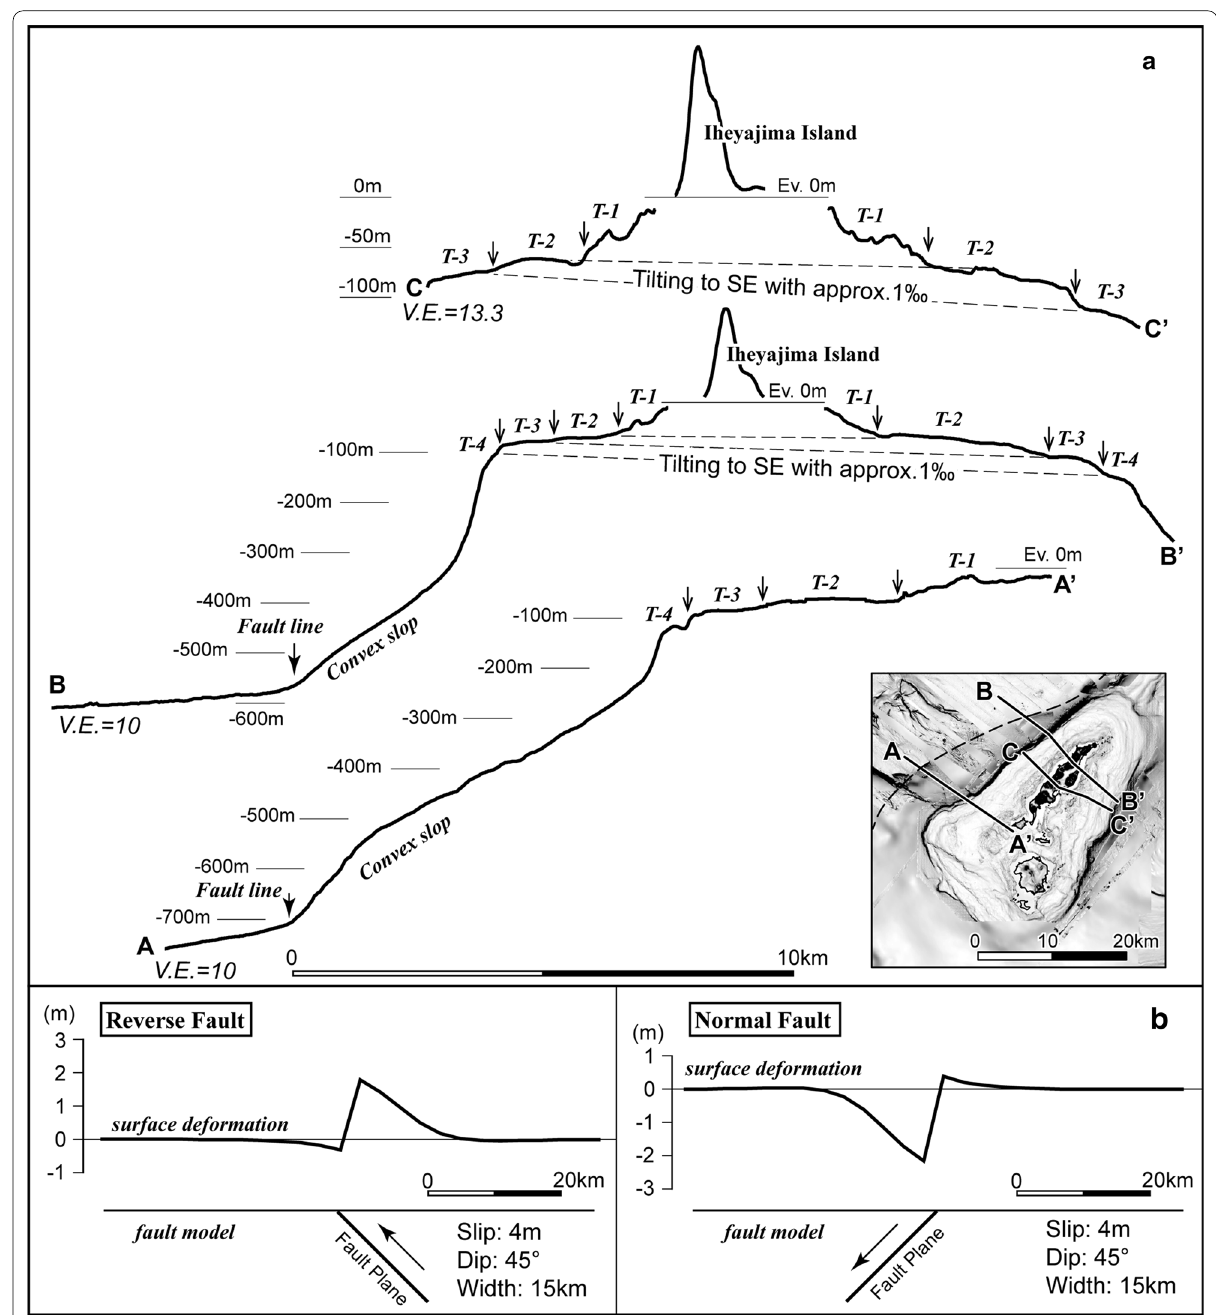
Fig. 4 Topographic profiles across the submarine terraces ( a ) and calculated vertical surface deformation ( b ). a Profile based on the DEM shown in Fig. 1C. The locations of the profiles used are shown in the lower right map and Fig. 2B. Downward open arrows indicate the boundaries of submarine terraces. b Vertical surface deformation across normal and reverse faults calculated by MICAP-G (Naito and Yoshikawa 1999), based on Okada